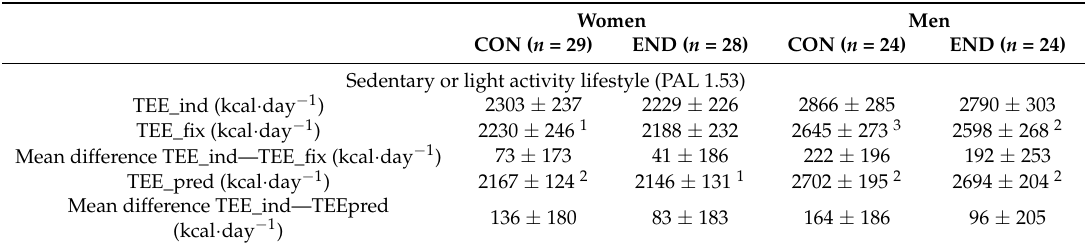
Table 4. Total energy expenditure (TEE) calculated with the individual (TEE_ind), conventional (TEE_fix), and predicted (TEE_pred) 1-MET value for a sedentary or light activity lifestyle (PAL 1.53), an active or moderately active lifestyle (PAL 1.76), and a vigorous or vigorous active lifestyle (PAL 2.25)